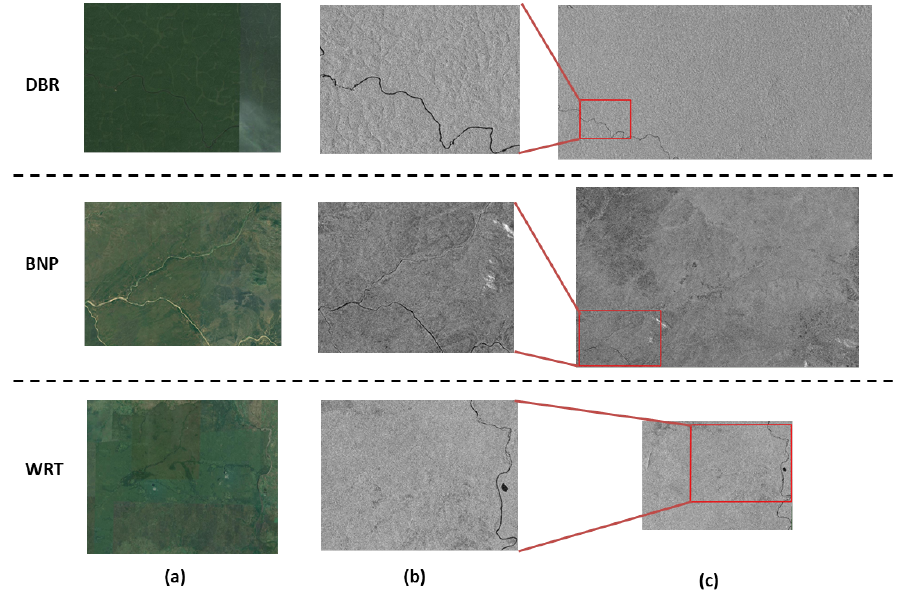
Figure 8. Representation of land parcels extracted from images for BNP, DBR, and WRT AOI: ( a ) RGB natural-color image of Google satellite sensor representing the extracted area; ( b ) view of the extracted area at scale 1:50,000; ( c ) image of the VH band representing the whole